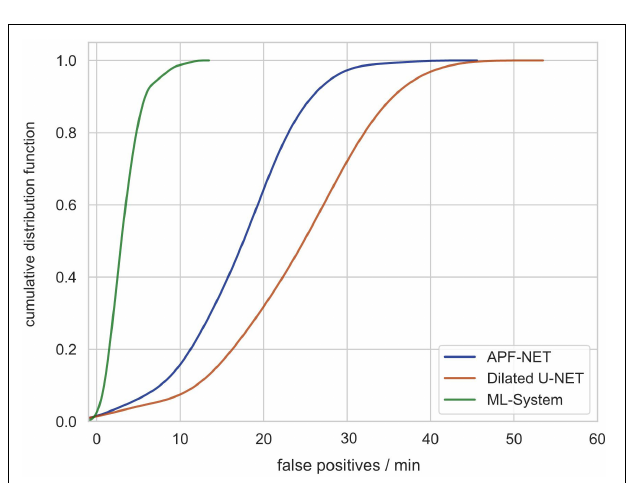
FIGURE 5 | The cumulative distribution function (CDF) of the number of false-positives generated per minute per video showing that the system can avoid most